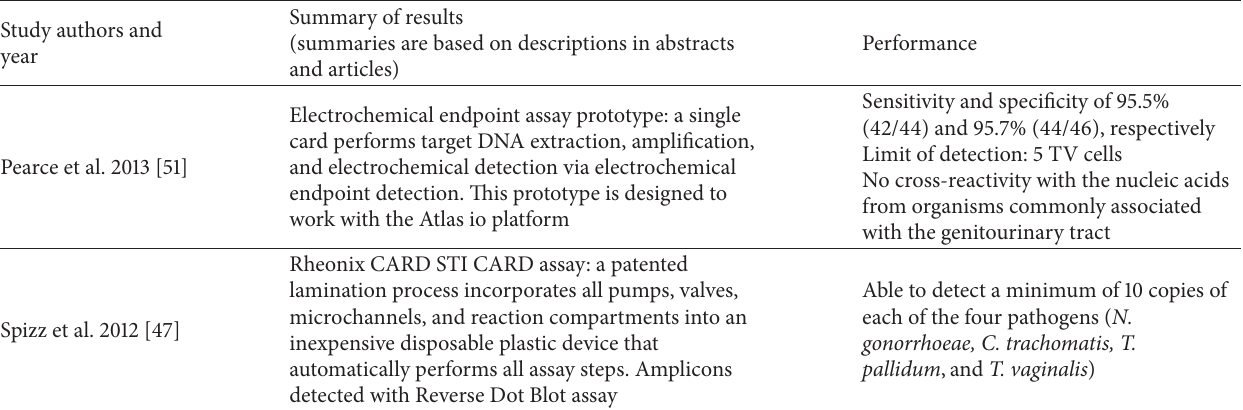
Table 6: Summary of proof of concept articles on point of care tests for Trichomonas vaginalis from 2010 to 2015. Study authors